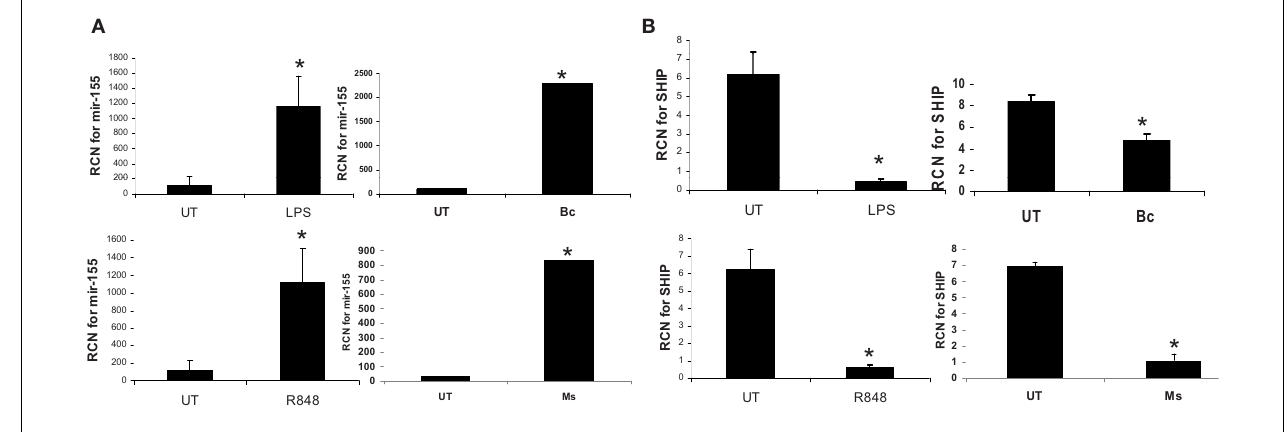
Ms in the figure) at MOI 5. mRNA was isolated from the cells 16h later and assayed by qRT-PCR for (A) miR-155 and (B) SHIP expression.These data are representative of six independent experiments. *Designates a p value < 0.05.